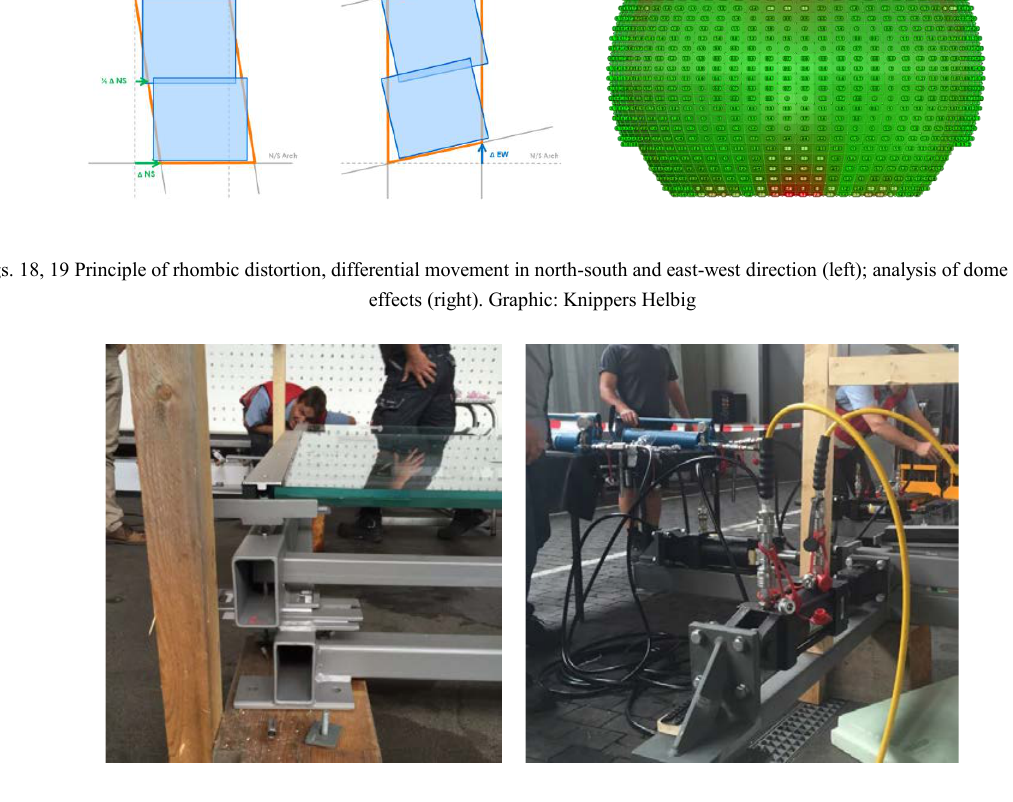
Figs. 20, 21 Principle of rhombic distortion, differential movement in north-south direction (left) and east-west direction (right). Images: Knippers